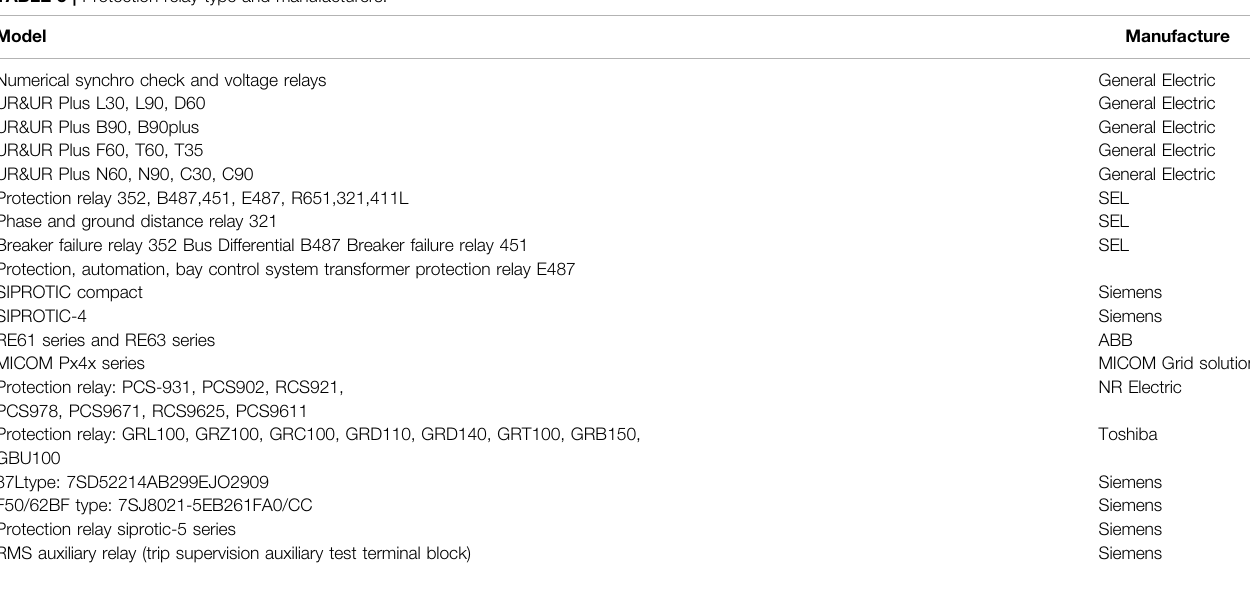
TABLE 5 | Protection relay type and